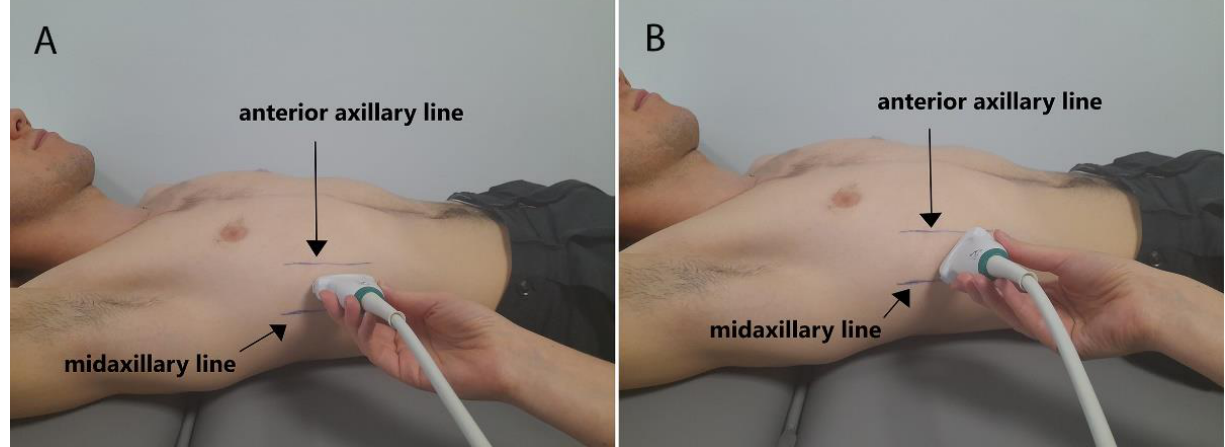
Figure 1. Illustration showing the placement of the transversally ( A ) and parallel to the ribs ( B ) ultrasound probe position.